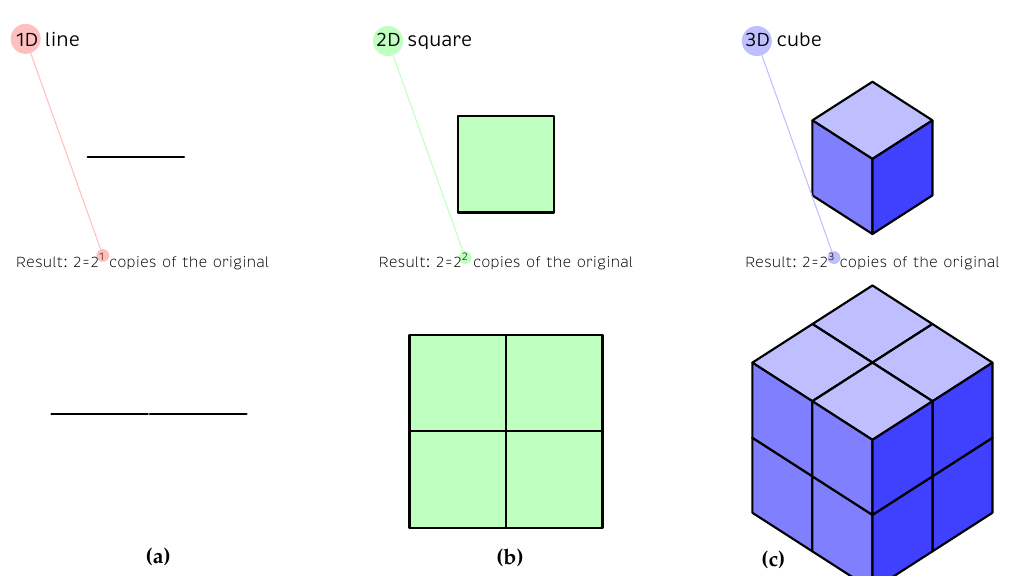
Figure 2. When objects of different dimension (e.g., ( a ) line, ( b ) square, and ( c ) cube) are linearly scaled by a factor of 2, their characteristic size will have different results associated to their